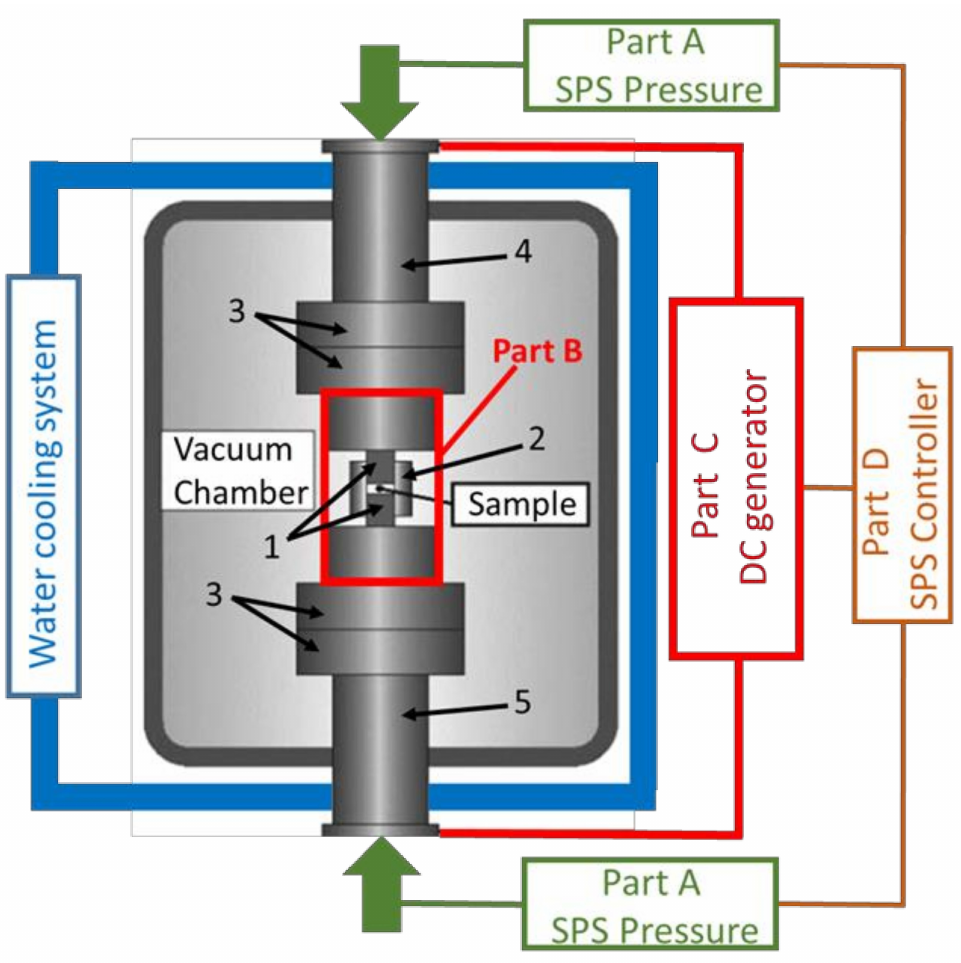
Figure 3. Schematic of an SPS apparatus. (1) Graphite punches. (2) Cylindrical die (usually in graphite). (3) Graphite spacers. (4) Upper water-cooled steel cylinder. (5) Lower water-cooled steel cylinder. Adapted from